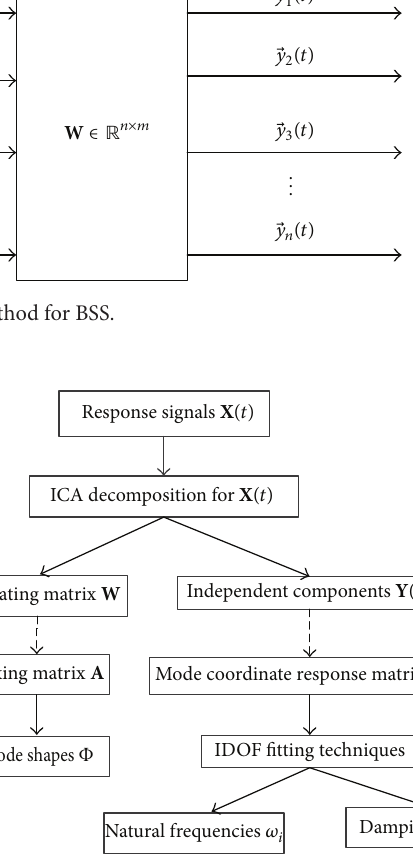
Figure 2: One-to-one corresponding relations between dynamic response modal coordinates decomposition and